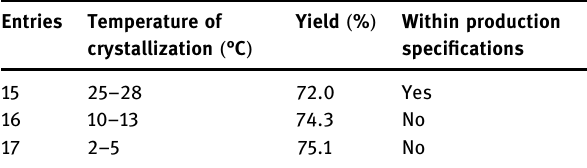
Volume of water/weight